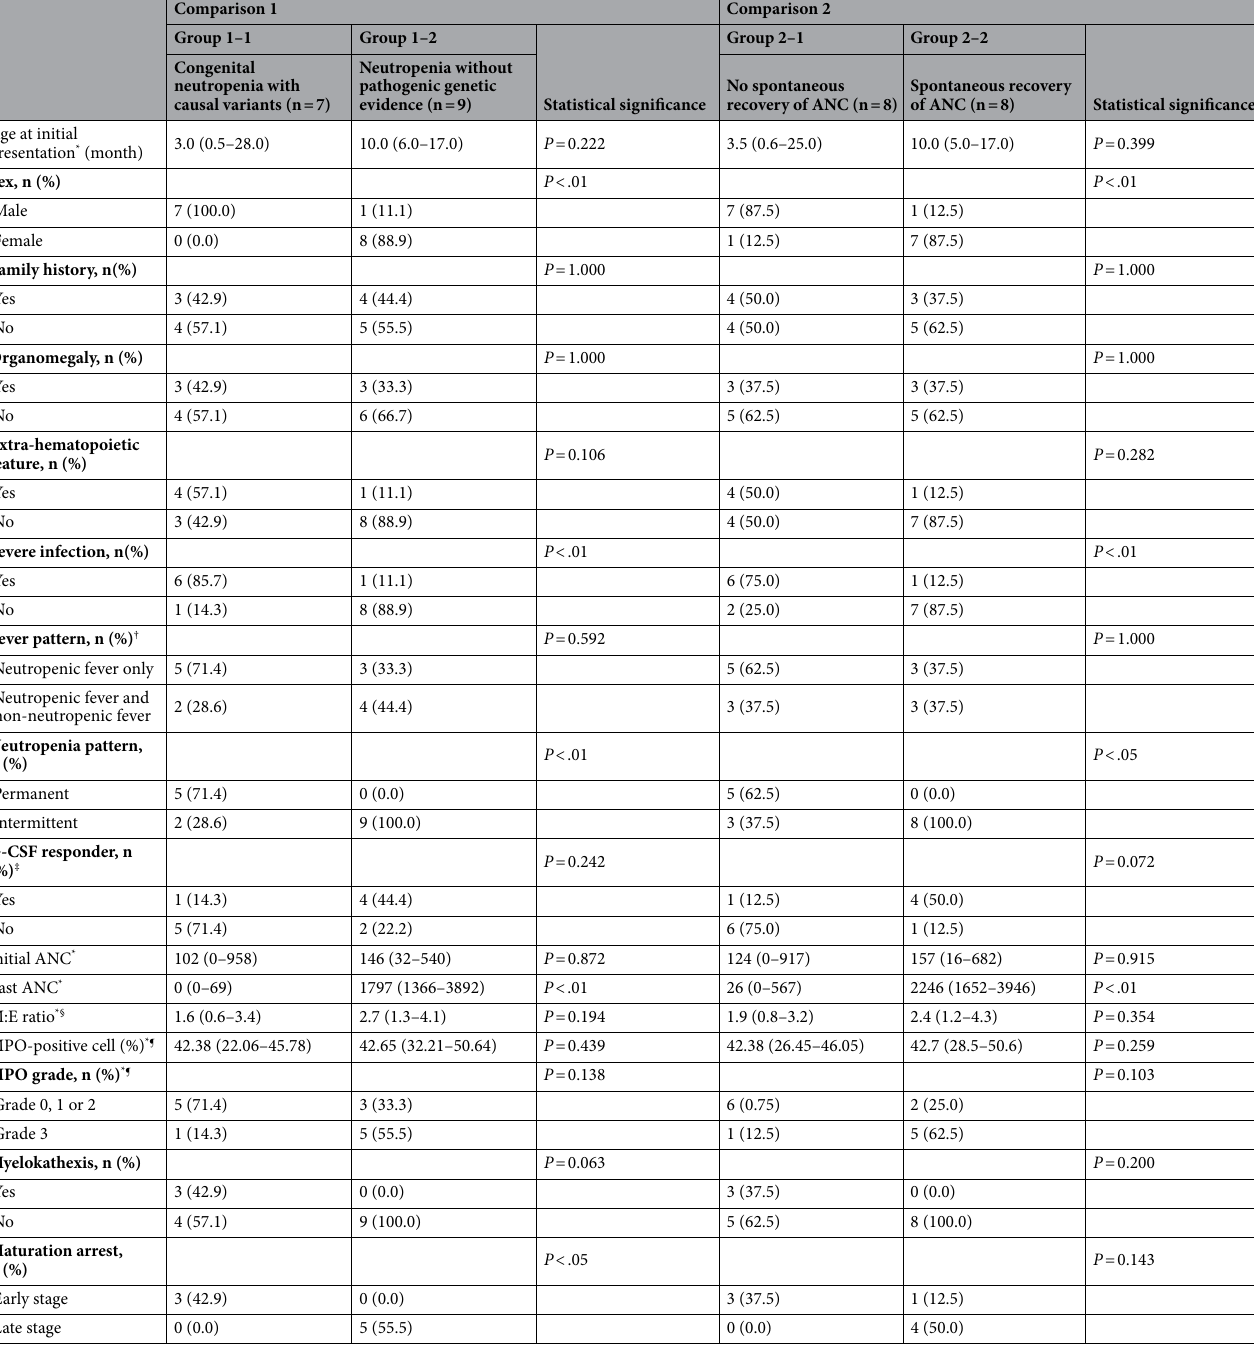
Table 2. Comparisons between groups based on genetic evidence or spontaneous recovery of ANC. * Values presented as medians (interquartile ranges). † Two patients who did not suffer from infection or fever during the follow-up period were excluded. ‡ Three (18.8%) patients in whom G-CSF was not administered were not included. Also, one patient who could not assess the response to G-CSF wereexcluded. § One patient with diluted BM aspiration in which reliable differential count could not be made was excluded. ¶ Two patients were not included due to inadequate BM section quality or retrospectively unavailable BM paraffin block for MPO stain. Abbreviations: BM, bone marrow; G-CSF, granulocyte-colony stimulating factor; M:E, myeloid to erythroid; MPO,